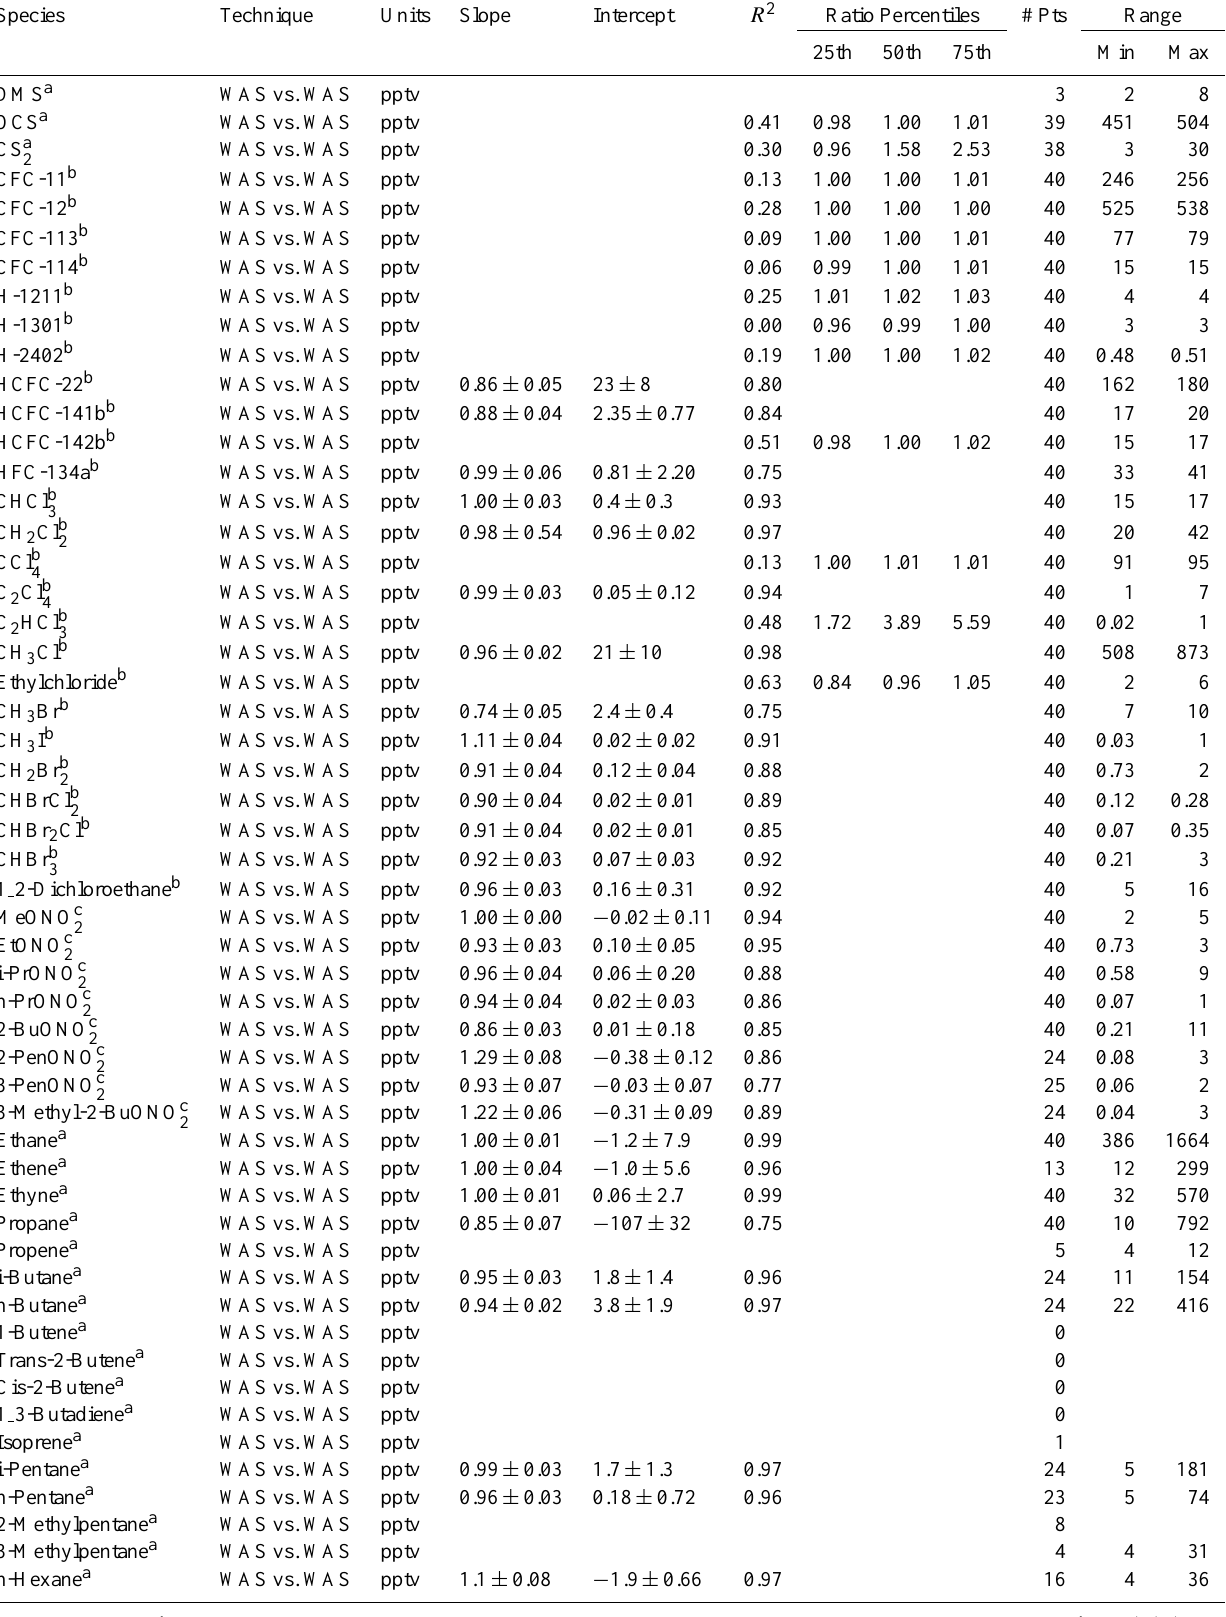
Table 3e. Statistical results of DC-8/C-130 intercomparison. Nonmethane hydrocarbons, halocarbons, alkylnitrates, and organic sulfur compounds. NOTE: Technique is listed as X (C-130) vs. Y (DC-8). Species Technique Units Slope Intercept